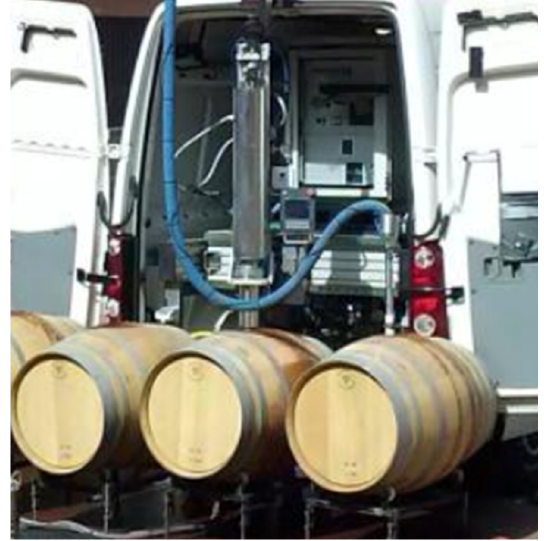
Figure 2. HPU apparatus.